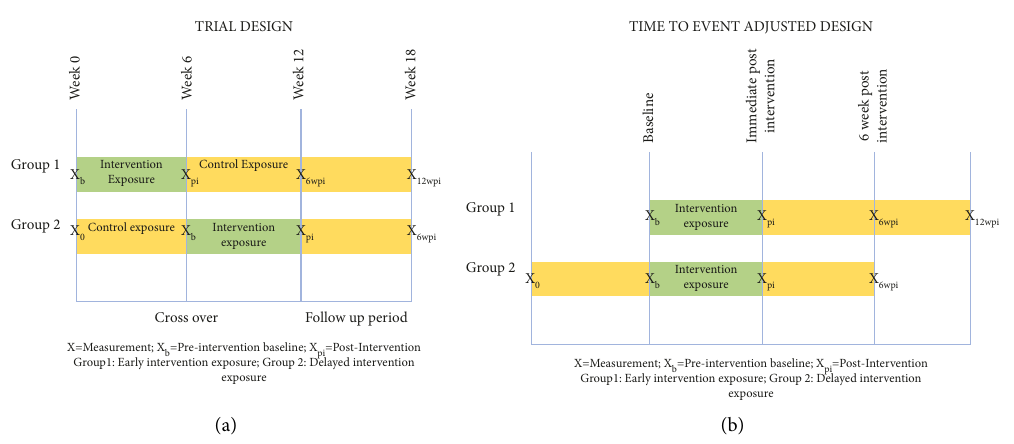
Figure 2: Study design. A closed cohort stepped wedge trial design with two groups (a) and a single cross-over design